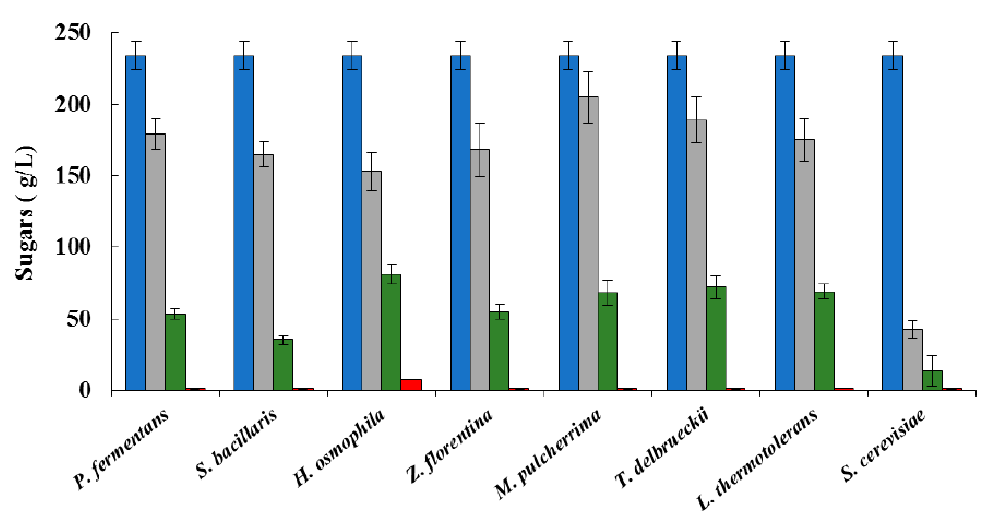
Figure 2. Non- Saccharomyces and S. cerevisiae sugar consumption in each fermentation trial. Different colors indicate different sampling times; T0 ( ■ ), T3 ( ■ ), T5 ( ■ ), T10 ( ■ ). Data are means ±SD ( n = 2).